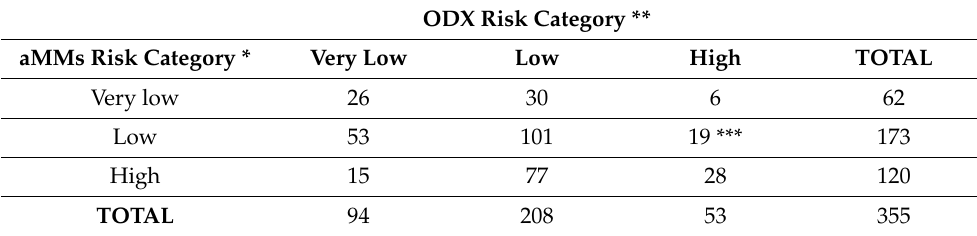
Table 4. Total population and associated risk